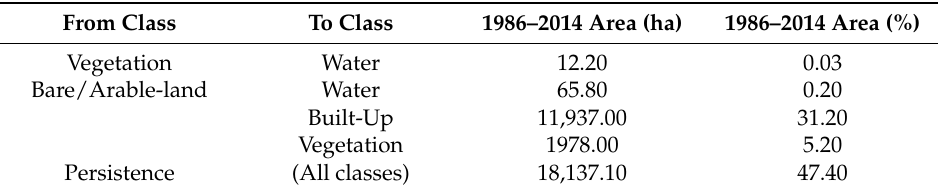
Table 11. Main LULC conversions from 1986 to